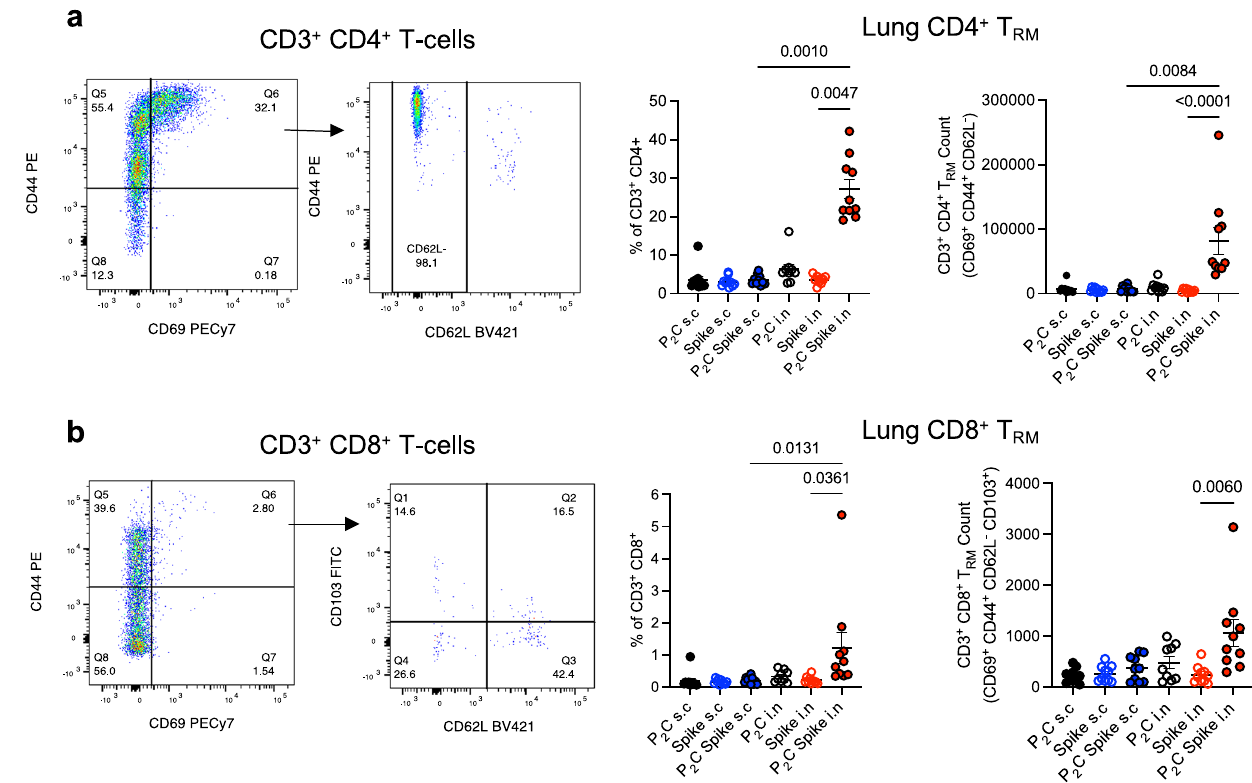
Fig. 4 | Mucosal vaccination induces lung localized Tissue Resident Memory (T RM )-likeT-cells. C57BL/6micewereimmunizedwithPam 2 Cys(P 2 C;black)and/or Spike sub-cutaneously (s.c; blue) or intra-nasally (i.n; red) three times, 2 weeks apart. At 8 weeks post- fi nal vaccination ( a ) T RM -like CD4 + T-cells (de fi ned as CD3 + CD4 + CD69 + CD44 + CD62L − ) and b T RM -like CD8 + T-cells (de fi ned as CD3 + CD8 +